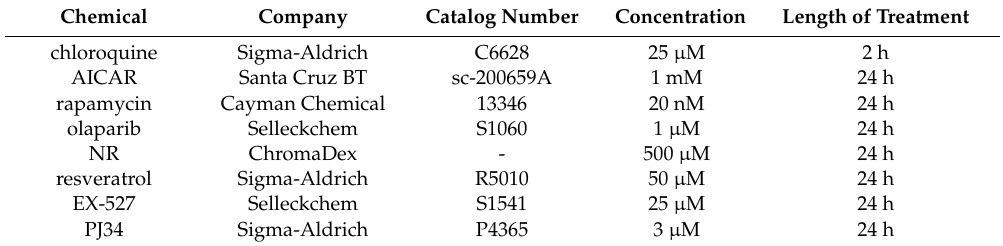
Table 1. The source of key chemicals used in the